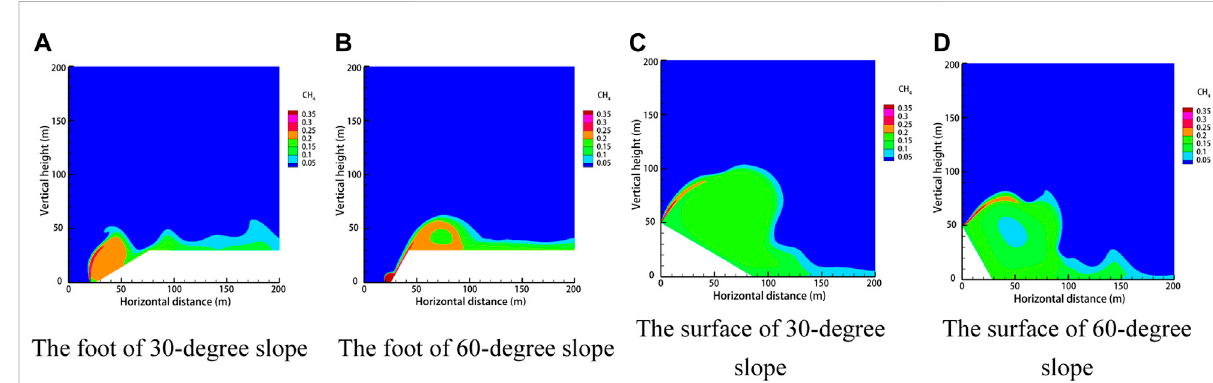
FIGURE 22 Dispersioncloudsofdifferentlayingenvironmentsafter60sofleakage. (A) Footof30-degreeslope. (B) Footof60-degreeslope. (C) Surfaceof 30-degree slope. (D) Surface of 60-degree slope.